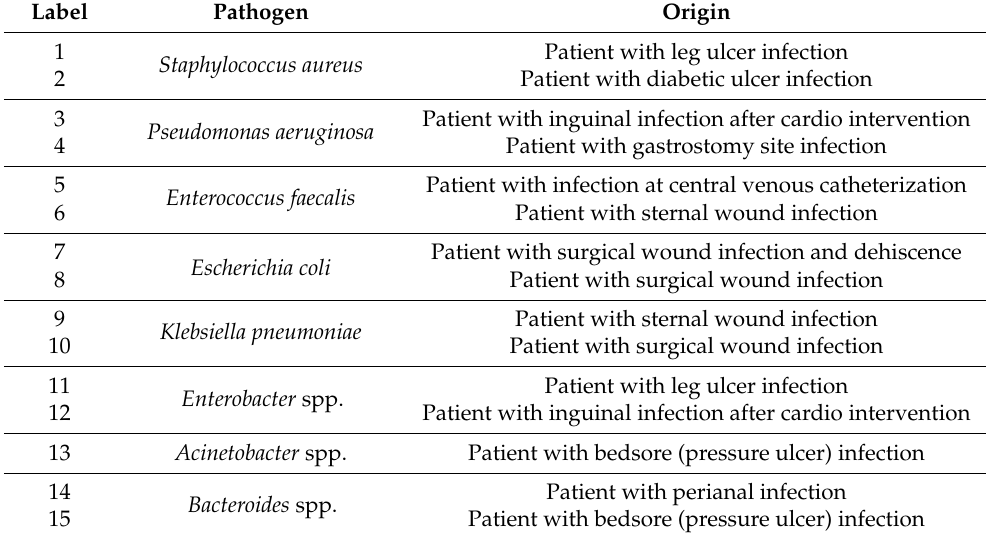
Table 3. Clinical pathogenic isolates and their